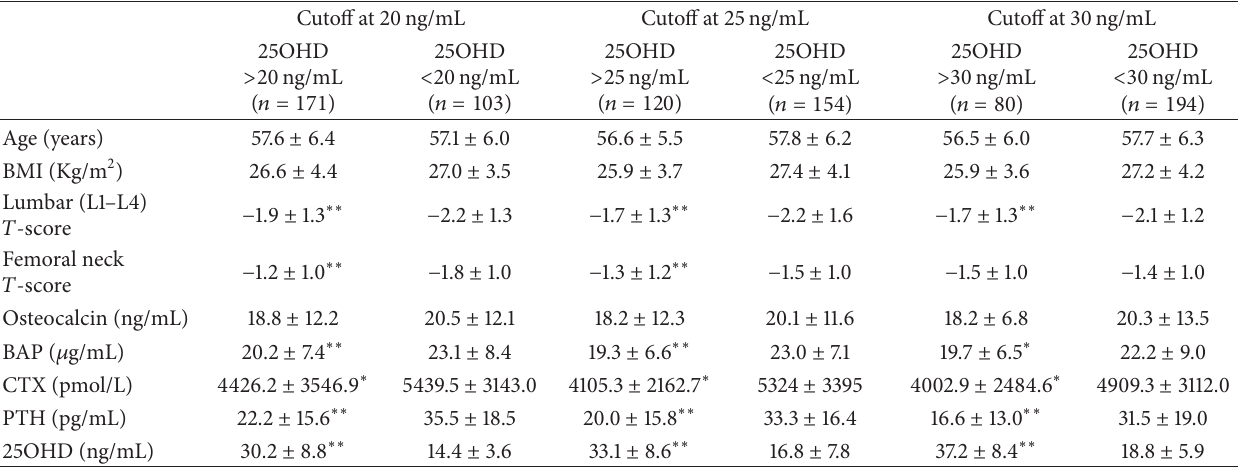
Table 2: Features, 𝑇 -scores, and biochemical markers of subjects subdivided three times into two groups on the basis of the different 25OHD cutoff values (20, 25, and 30